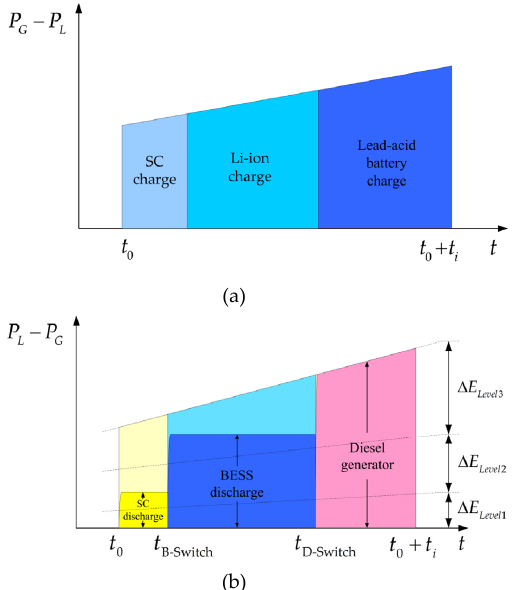
Figure 5. Operation status and coordination strategy of power sources in different conditions. ( a ) Illustration of charging process; ( b ) Illustration of discharging process. SC, super capacitor. A flowchart of the proposed strategy is illustrated in Figure 6.